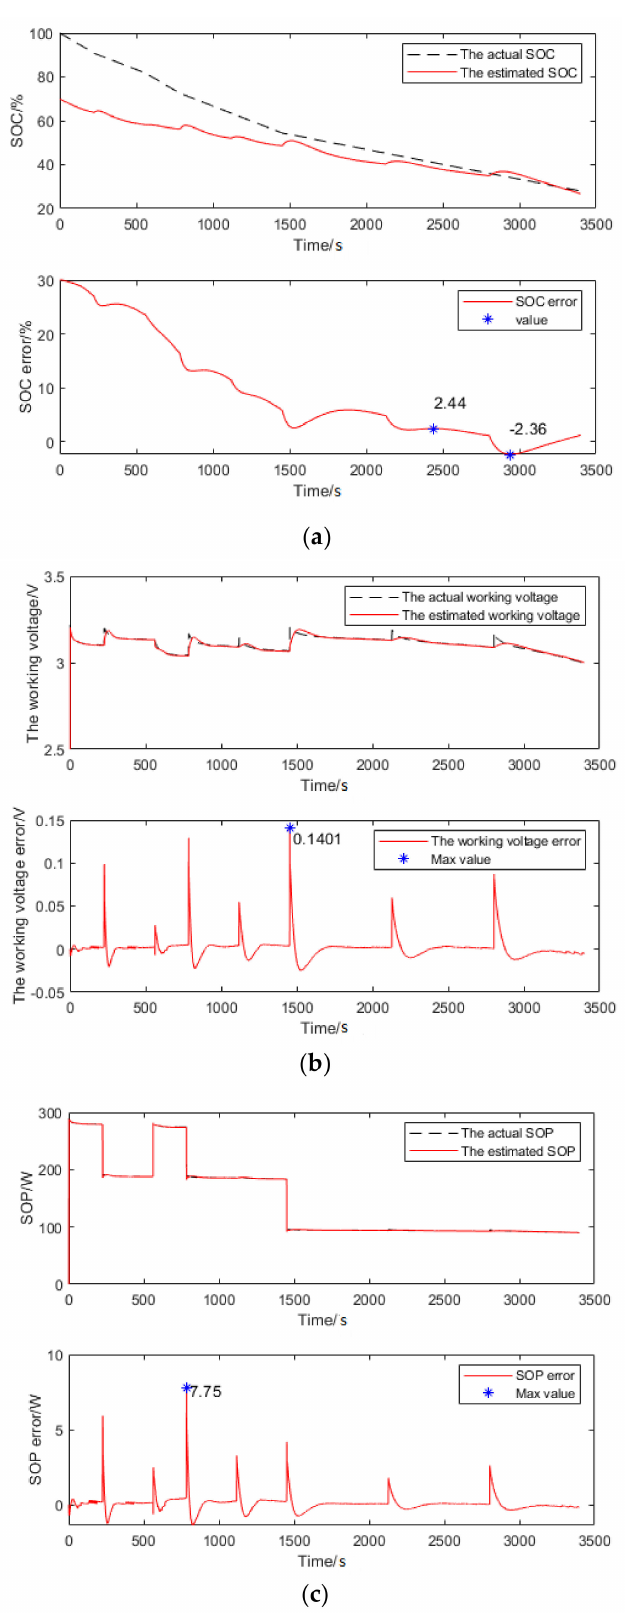
Figure 5. The simulation verification curve when the initial value of the SOC is 70%. ( a ) The SOC estimation and error curves. ( b ) The working voltage estimation and error curves. ( c ) The SOP estimation and error